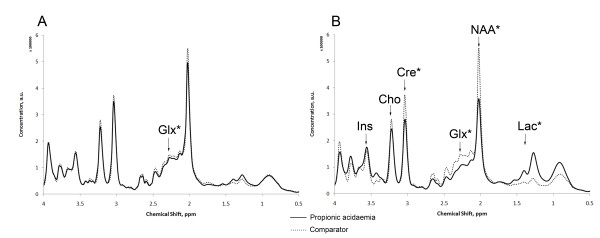
Mean MR spectra from basal ganglia during metabolic stability and acute encephalopathy in propionic acidaemia. (A) Metabolically stable and (B) acutely encephalopathic propionic acidaemia patients compared to normal imaging comparator cohort. ppm, parts per million; a.u., arbitrary units. Major metabolite peaks identified (labelled arrows), significant differences indicated by *. Glx, glutamine + glutamate; Ins, myo-inositol; Cre, Creatine; NAA, N-acetylaspartate; Lac, lactic acid.